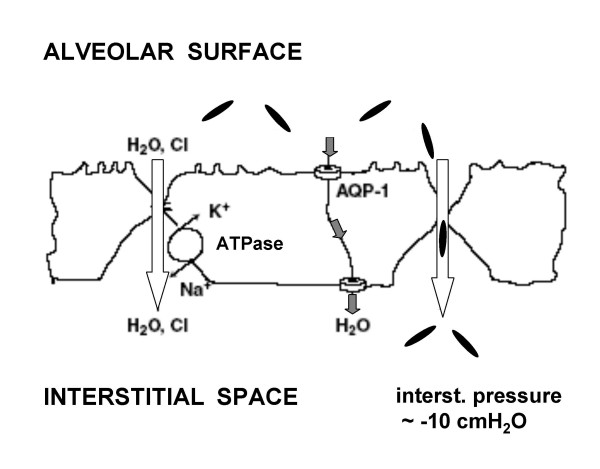
Uptake of asbestos fibers (in black) via the paracellular pathway down the physiological water absorption is favoured by the subatmospheric interstitial pressure and by the osmotic gradient generated in the baso-lateral spaces by the activity of Na+/K+ ATP-ase pump. A death of alveolar epithelial cells after asbestos fibers phagocytosis followed by desquamation of the alveolar lining may represent another translocation pathway. Transcellular water through aquaporins (AQP-1) is also shown.